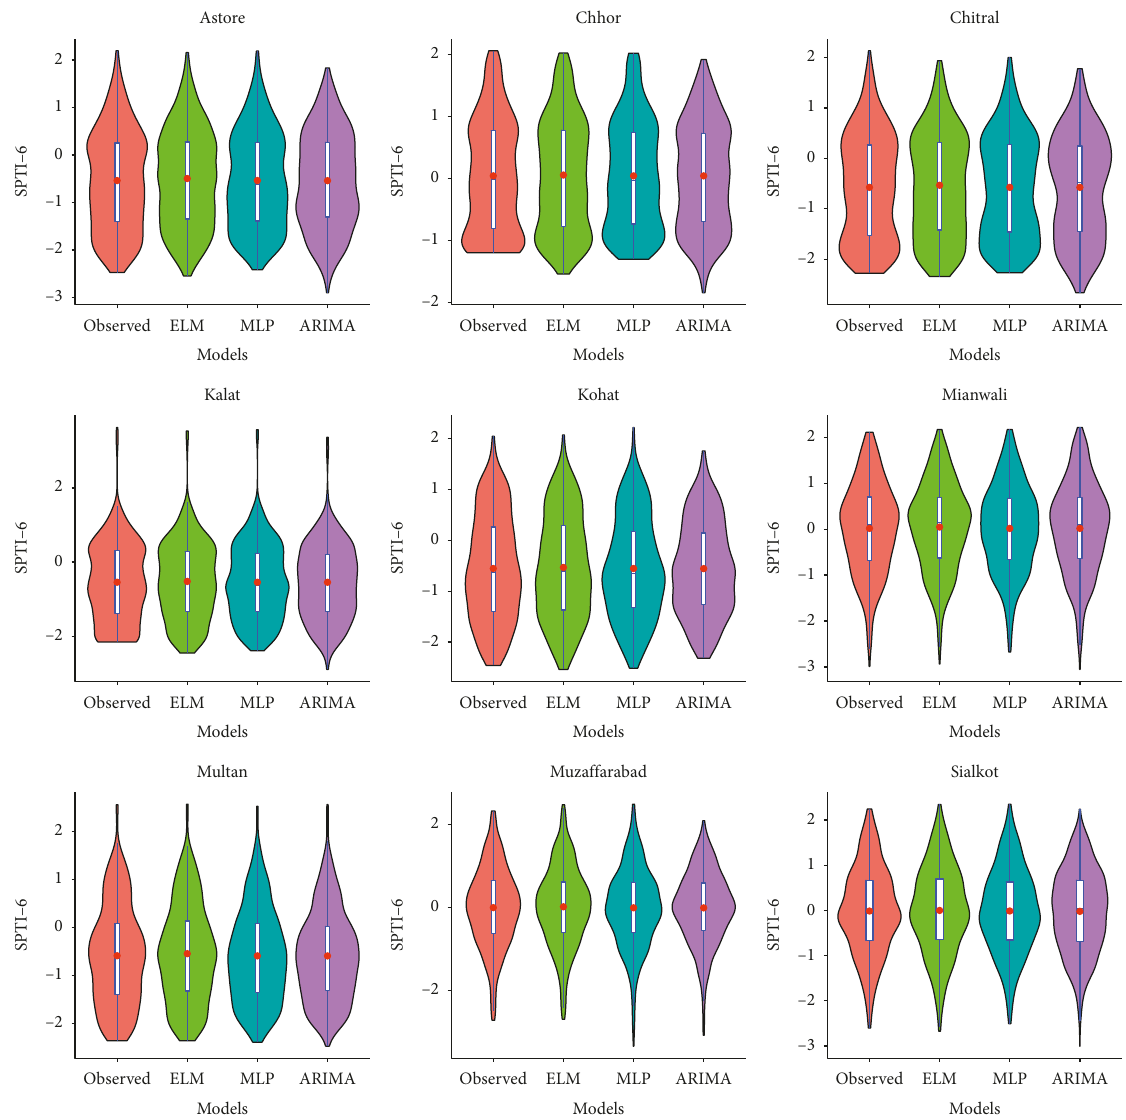
Figure 12: Violin plots of the observed SPTI-6 and the modeled data using ELM, MLP, and ARIMA models at all the selected meteorological stations in the training